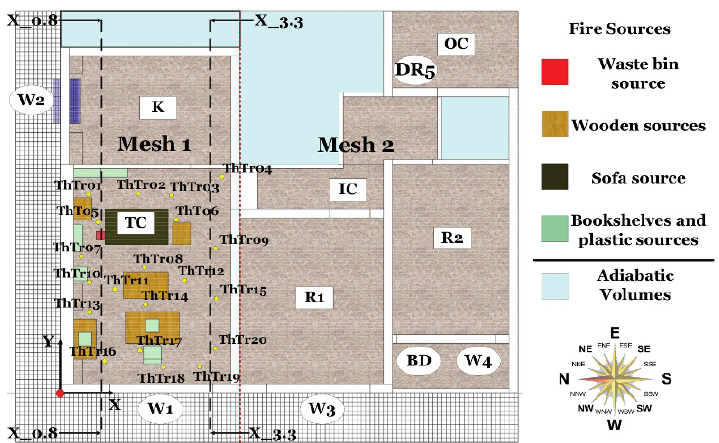
Figure 6. Numerical grid, fire sources and thermocouple trees.